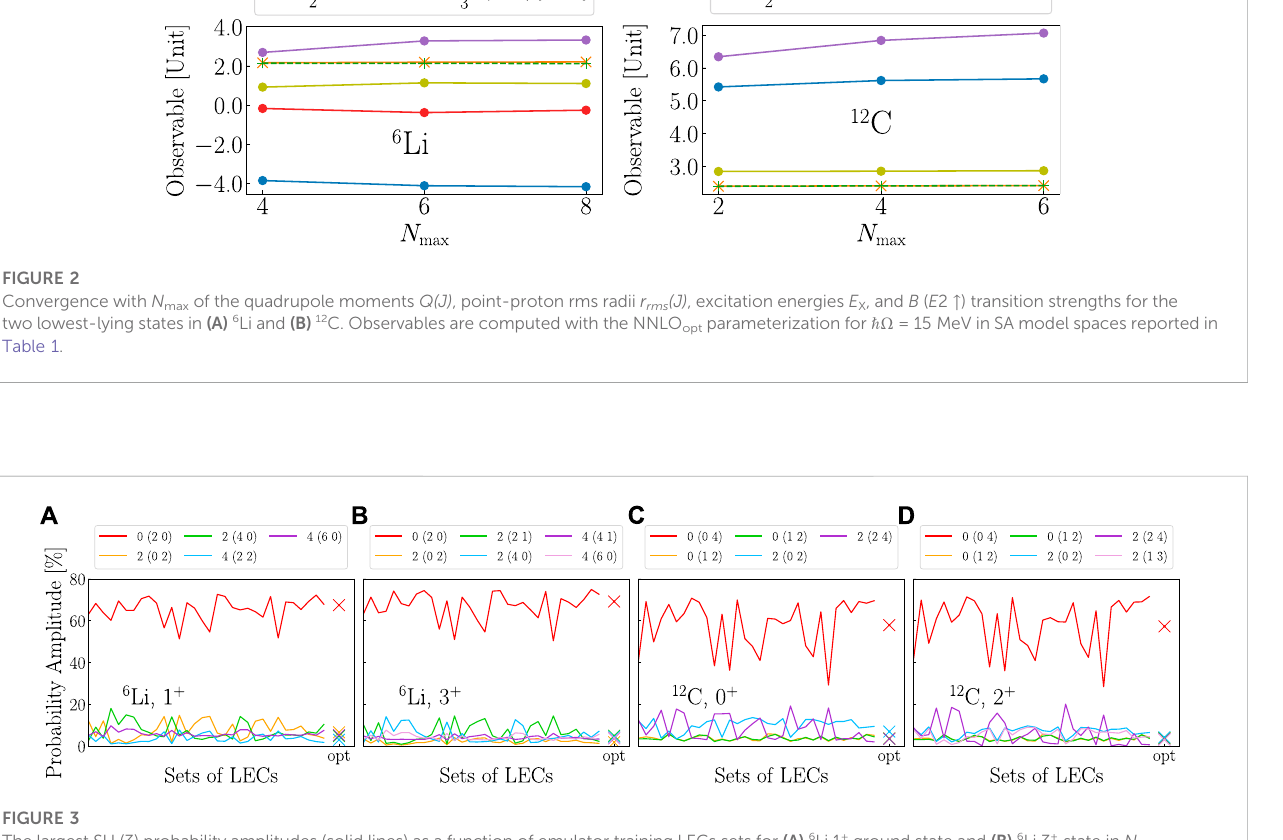
{ S , S n , S } (cid:1) { 1 , 1 , 1 } ],aswellasfor (C) 12 C0 + groundstateand (D) 12 C2 + p 2 2 S n , S } = {0, 1, 1} (orange) and {1, 0, 1} (green)]. Results are also shown for the NNLO p ,